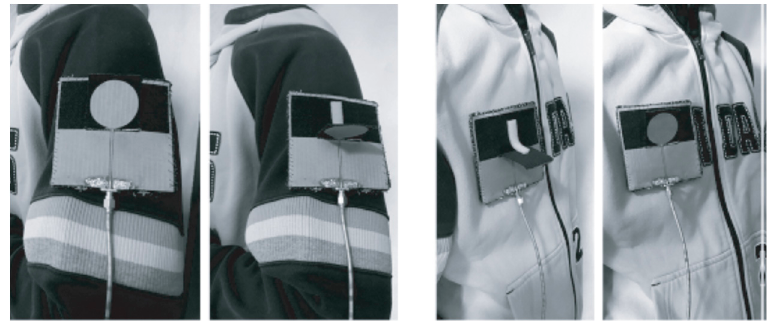
Figure 6. The measurement set-up for proposed fully textile reconfigurable UWB antenna with two monopole-like and a microstrip-like patterns ([89], reproduced courtesy of The Electromagnetics Academy).